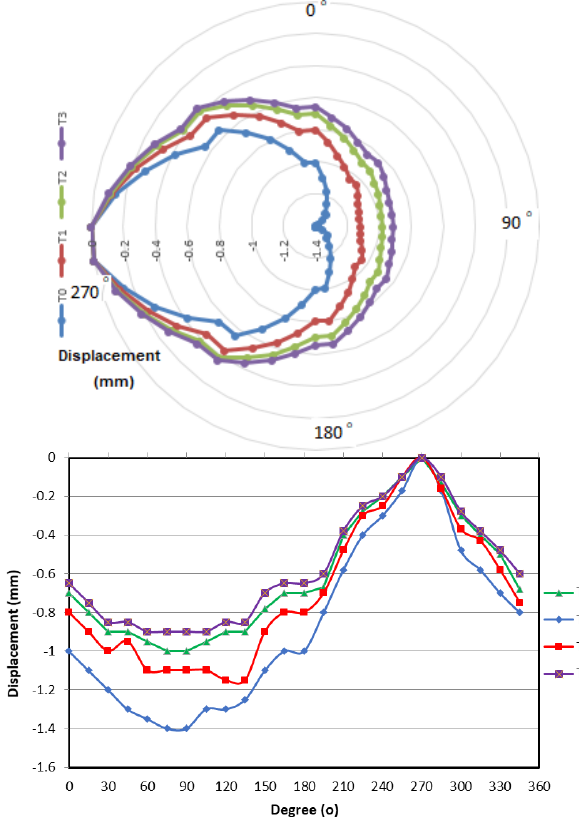
Figure 18: Horizontal displacement on the tunnel lining in different